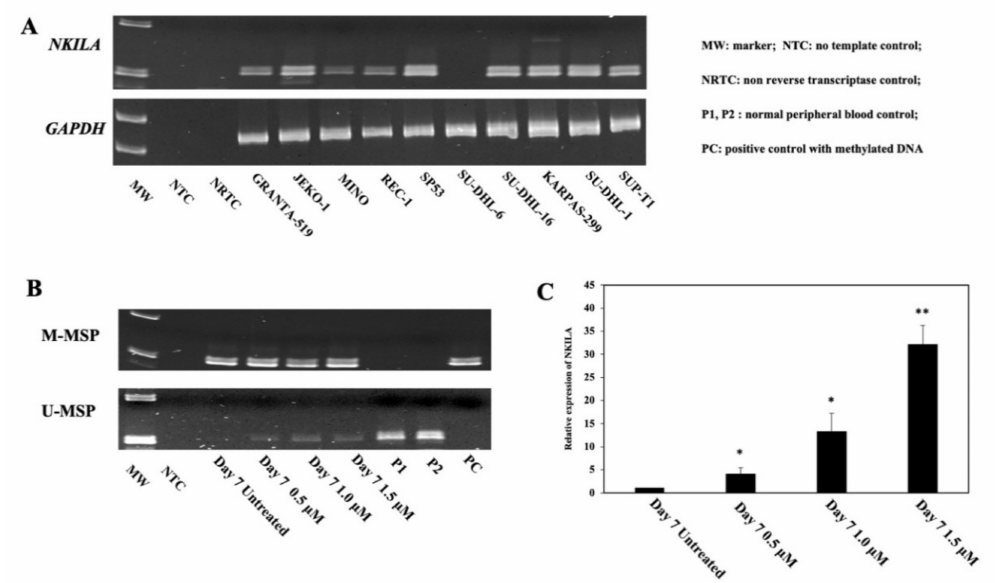
Figure 2. Correlation of promoter DNA methylation of NKILA and its expression in NHL cell lines. ( A ) NKILA methylation measured by MSP is associated with a lower expression of NKILA in NHL cell lines by semi-quantitative RT-PCR. ( B , C ) Treatment of SU-DHL-6 cells completely methylated for NKILA with 5-AzadC for 7 days, leads to NKILA promoter demethylation detected by MSP ( B ) and associated with the re-expression of NKILA by qRT-PCR ( C ). Columns represent mean +/ − 1SD from three qRT-PCR experiments in triplicate. *: Compared with untreated cells, p -value < 0.05, **: Compared with untreated cells, p -value <